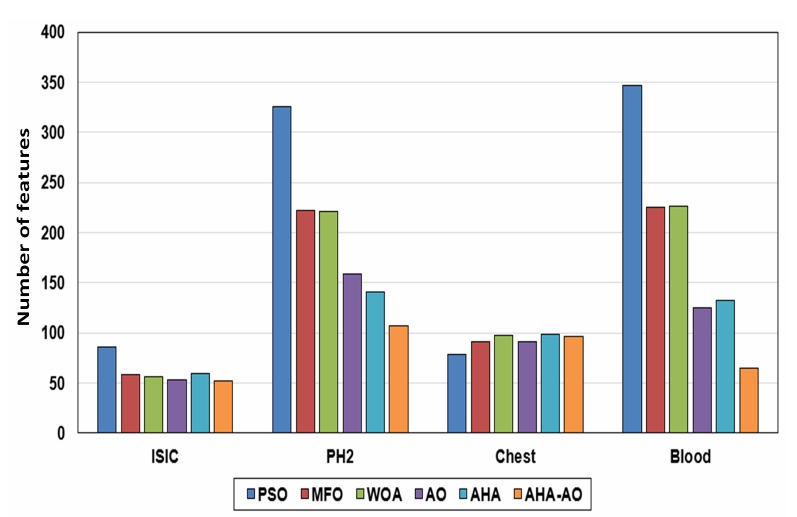
Figure 6. Numbers of selected features of different optimizers for all datasets.